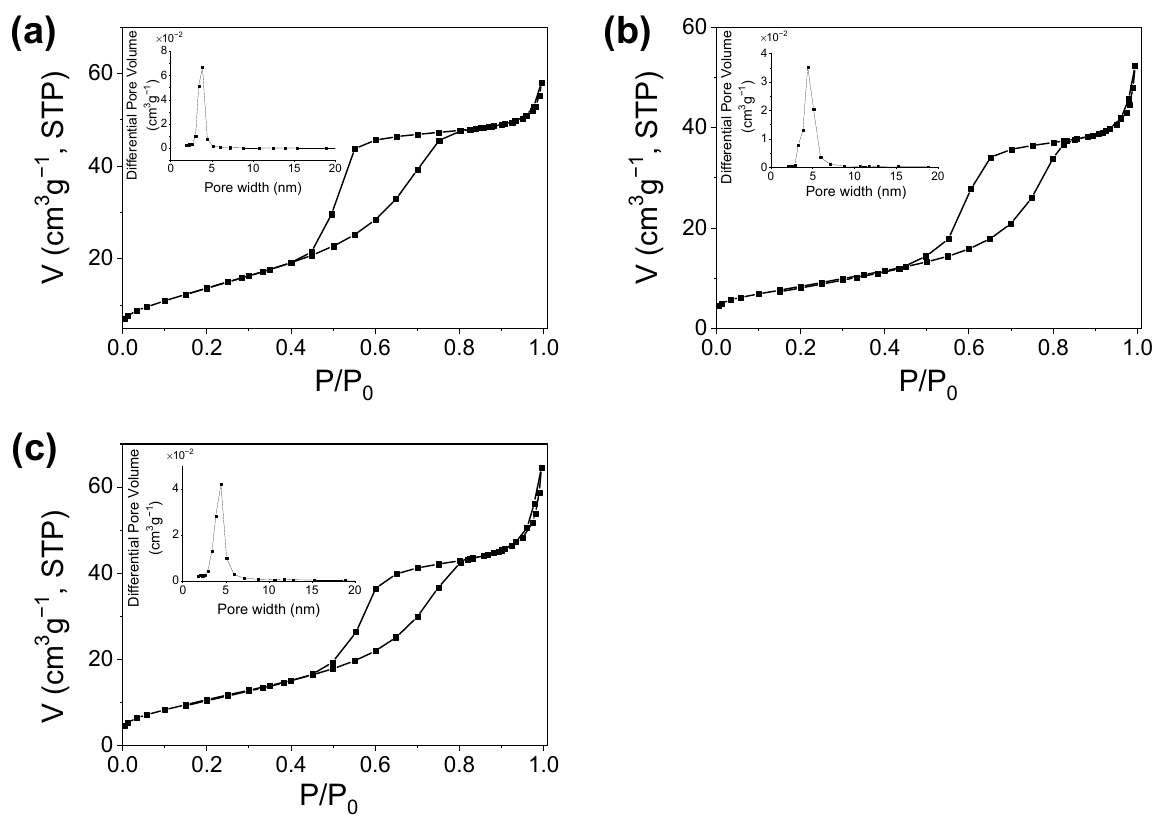
Figure 13. N 2 adsorption–desorption isotherms and pore size distributions (inset of the figures) of